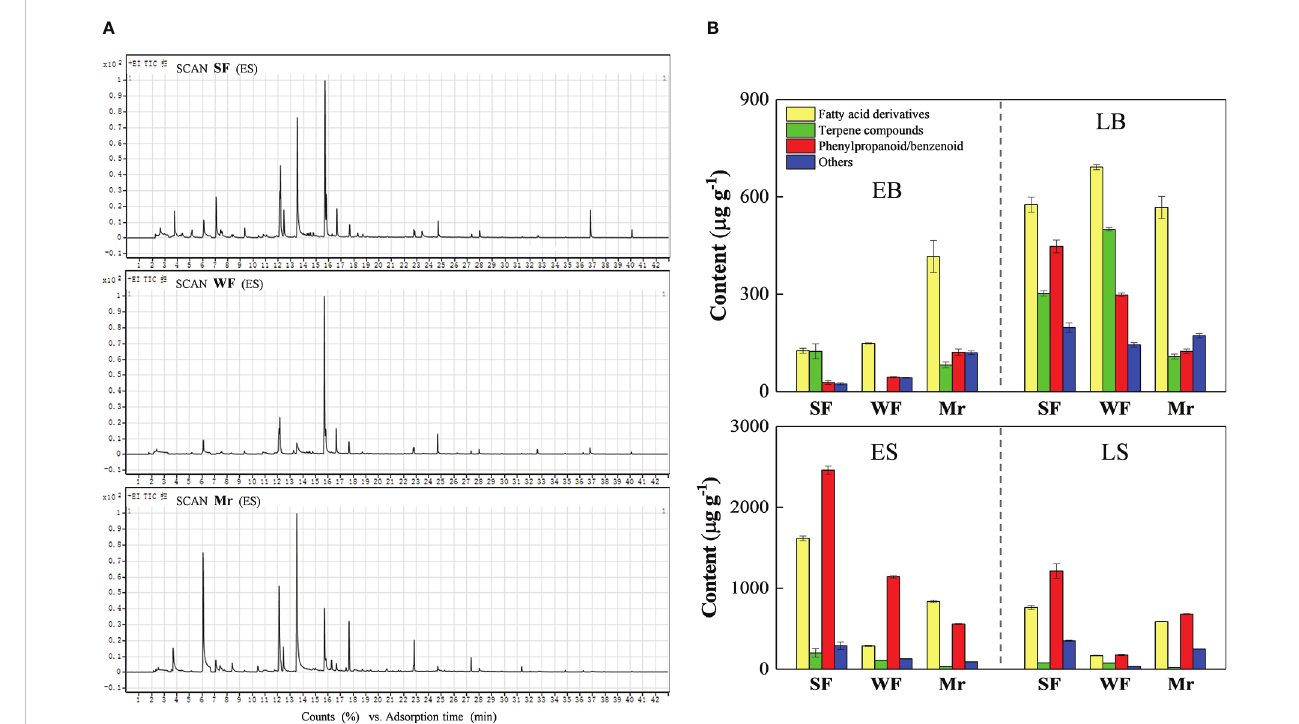
FIGURE 2 Chromatograms and composition of fl oral scent volatiles in the Malus robusta materials. (A) , Chromatograms for strongly fragrant (SF), standard (Mr), and weakly fragrant (WF) fl owers at the early fl owering stage. (B) , Composition and species number of volatiles at four stages of fl oral development. Data represent the means (n= 3).